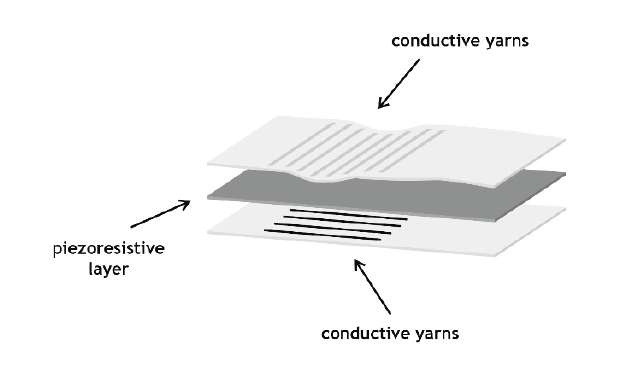
Figure 1. Schematic illustration of the piezoresistive textile bending